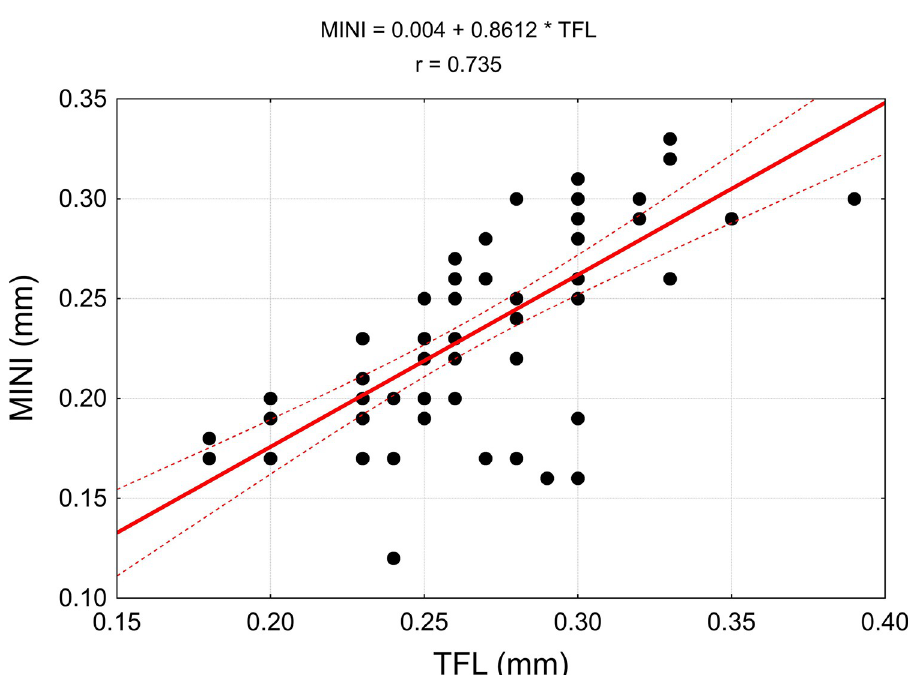
Fig 17. Correlation diagrams for the width of the nerve branch to the tensor fasciae latae muscle (TFL) with the width of the piriformis muscle (MP), the width of the main branch to the gluteus medius muscle (MED), the average width of the branches emerging from the main trunk of the nerve to the gluteus minimus muscle (MINI) and the average total width of the branches departing from the main trunk of the examined nerve (MINI bis).